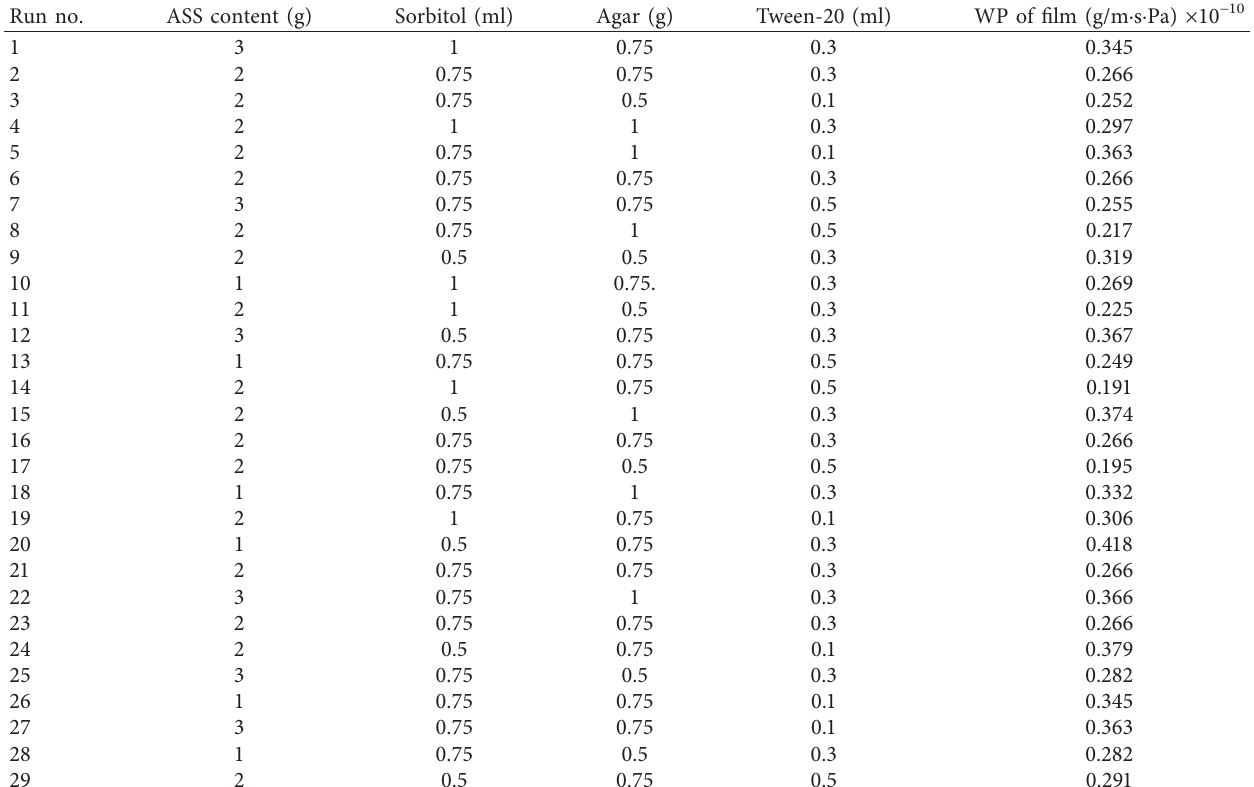
Table 1: Design combination of process variables and obtained responses (WP). Run no.